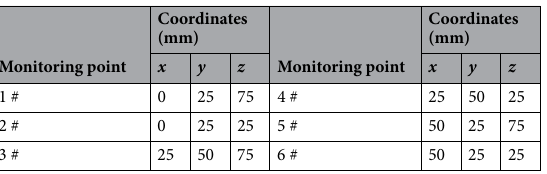
Table 1. Coordinates of AE monitoring points for the moment tensor